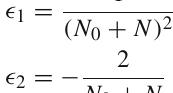
Fig. 2 Upper graph: The scalar field potential V (φ) in the Einstein frame of the Starobinsky inflation. Lower graph: The corresponding scale factor potential U ( a ) as it is numerically reconstructed from the solution of Eqs. (28)–(31). Inflation ends at the global minimum of U ( a ) , and its subsequent oscillations correspond to the scalar oscilla- tions around the minimum of V (φ) during the reheating phase. We use units where 8 π G = 1 and we set the scale factor at the beginning of inflation to a i =